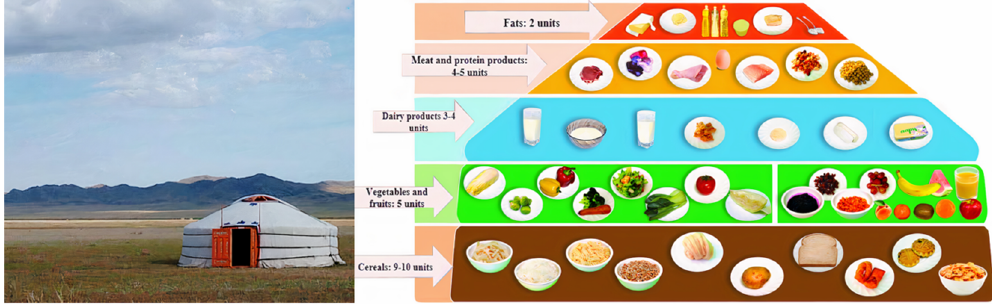
Figure 1. Mongolian nomadic felt house (Ger) and the “Ger Recommendations”.